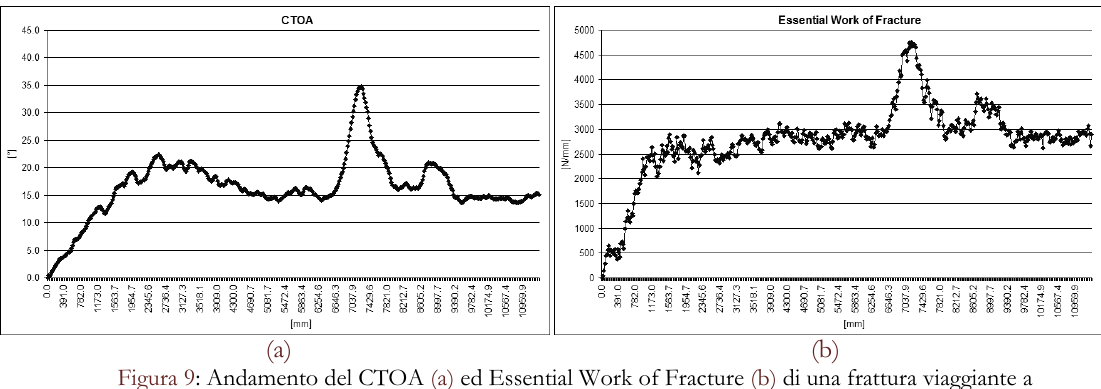
Figura 9: Andamento del CTOA (a) ed Essential Work of Fracture (b) di una frattura viaggiante a